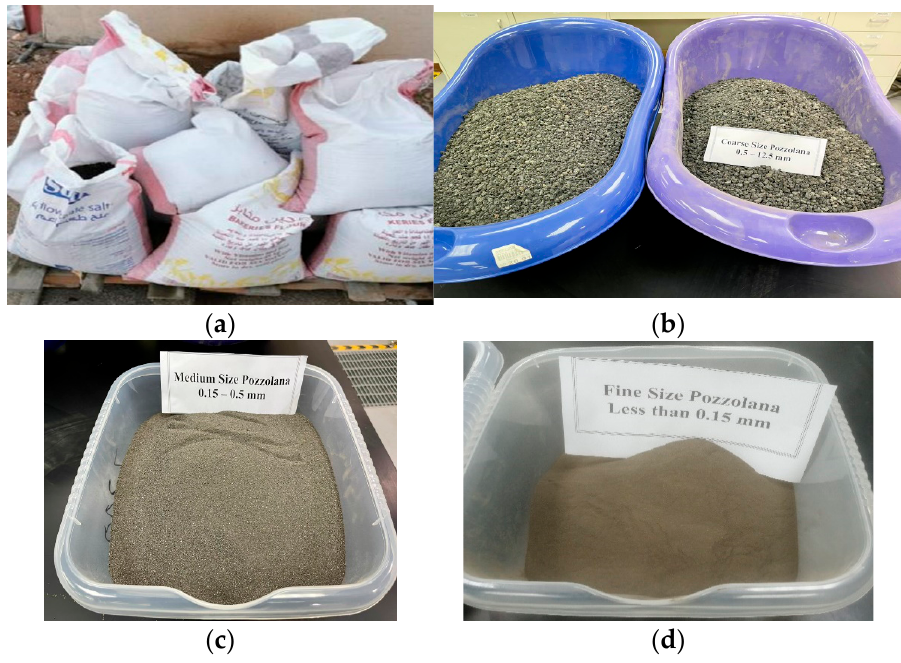
Figure 2. Pozzolan sample: ( a ) as-received and ( b ) coarse, ( c ) medium, and ( d ) fine-size fractions. Chemical analyses showed that the study pozzolan had a SiO 2 + Al 2 O 3 + Fe 2 O 3 content of 78.47% and a loss on ignition (LOI) of 3.25 wt.% (Table 1). Thus, it is classified as a